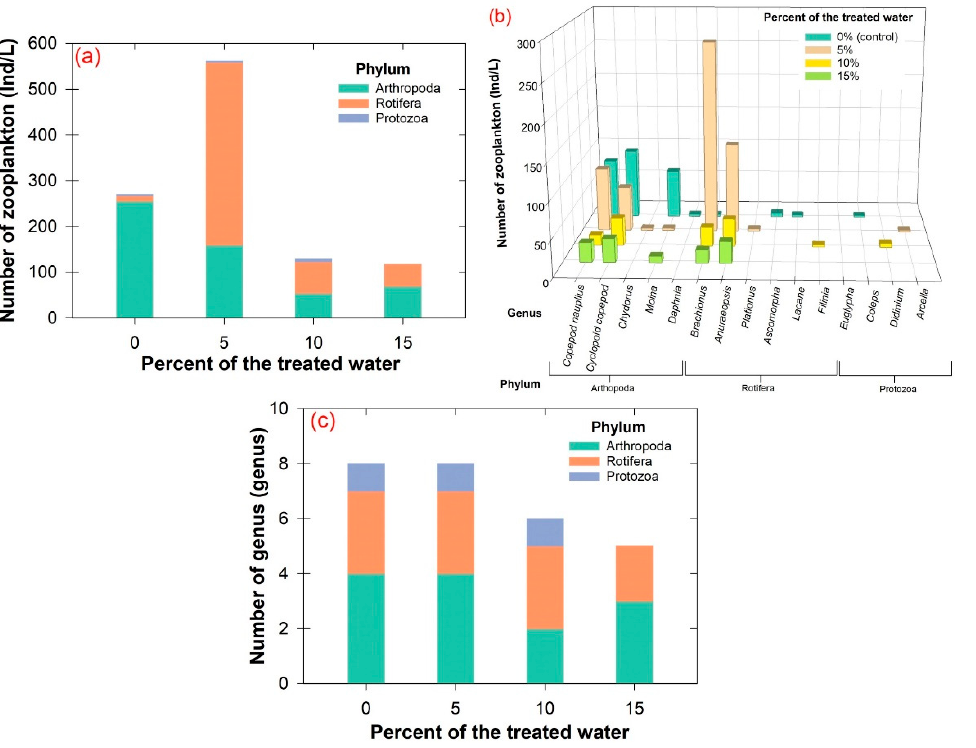
Figure 9. ( a ) Changes in number of zooplankton categorized by phylum, ( b ) categorized by genus, and ( c ) changes in number of genera after exposure to different percentages of the treated water (0–15%).